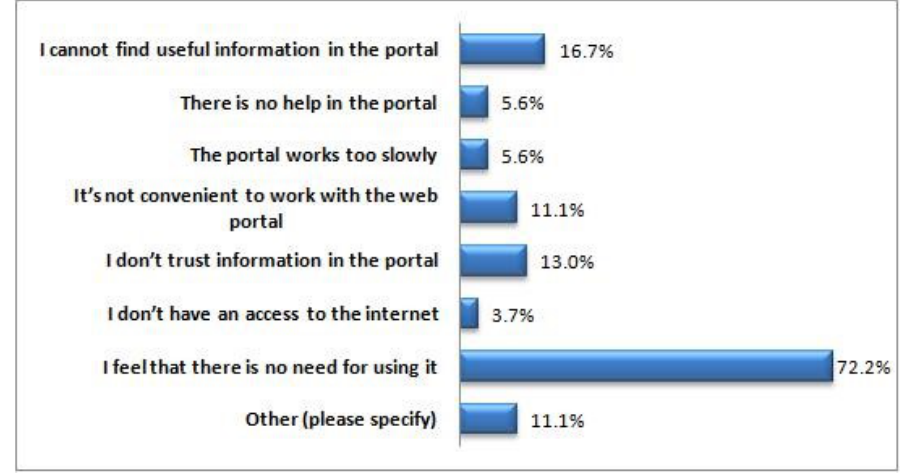
Figure 4. Barriers for not using e-Government